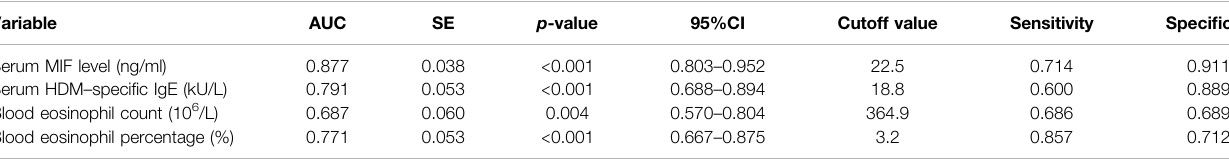
TABLE 5 | ROC analysis results of different variables for predicting clinical ef fi cacy of SLIT. Variable AUC SE p -value 95%CI Cutoff value Sensitivity Speci fi city Serum MIF level (ng/ml) 0.877